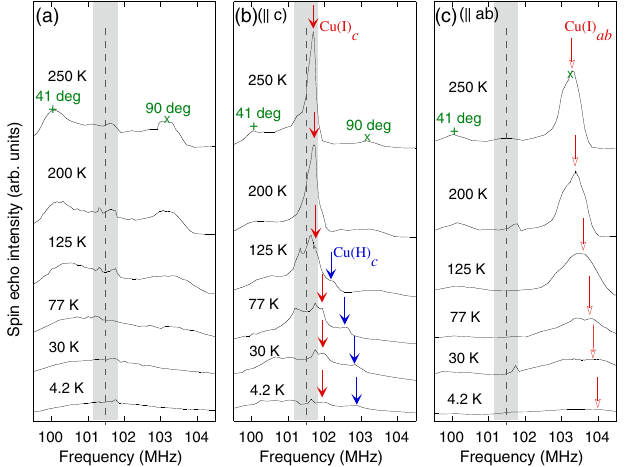
FIG. 9. (a) Representative 63 Cu NMR line shapes observed for an unaligned powder sample in an external magnetic field B 9 T. Green × and þ mark the peaks corresponding to ext ¼ the particles in which B is 90-deg (i.e., ab plane) and 41-deg ext tilted from the main principal axis of the electric field gradient tensor along the c axis. The gray shaded region is superposed by weak 23 Na NMR signals centered at ∼ 101 . 3 MHz arising from a small amount of impurity phase and the background 63 Cu NMR signals at ∼ 101 . 7 MHz from the metallic parts used in our cryogenic NMR probe. Dashed vertical line shows the unshifted 63 Cu NMR frequency 63 ν γ B . (b) Representative 63 Cu o ¼ n ext NMR line shapes observed for a uniaxially aligned powder 9 T applied along the aligned c axis. Red filled sample in B ext ¼ arrows mark the 63 Cu ð I Þ peak, while the blue filled arrows mark c geometry. (c) Representative the 63 Cu ð H Þ peak, both in the B ext jj 63 Cu NMR line shapes observed for a uniaxially aligned powder 9 T applied along the aligned ab plane. Red sample in B ext ¼ ab open arrows mark the 63 Cu ð I Þ peak in B ext jj